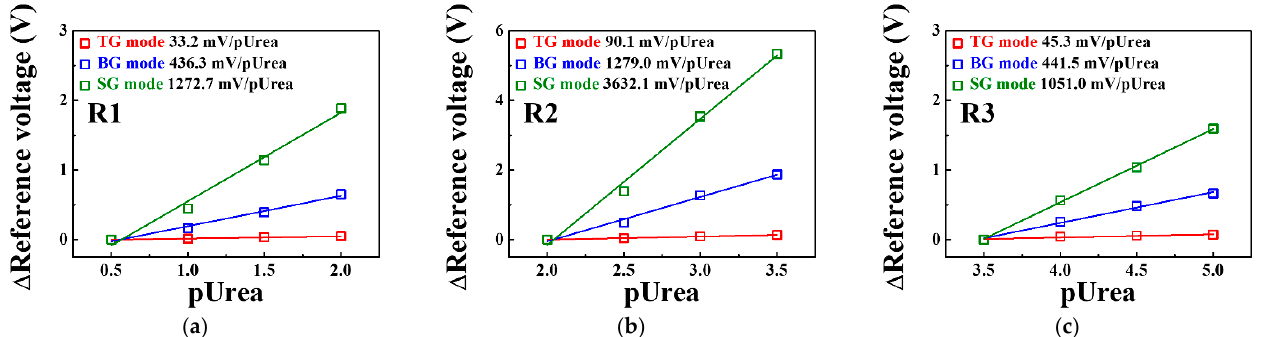
( d ) Figure 10. Transfer characteristic curves in urea-urea reactions of the triple-gate a-IGZO TFT-based urea-EnFET sensor platform in the ( a ) TG, ( b ) BG, and ( c ) SG modes for various urea concentrations. ( d ) Change in the reference voltage of the triple-gate a-IGZO TFT-based urea-EnFET sensor platform as a function of pUrea. Figure 11 shows the urea sensitivity for the SG, BG, and TG modes of the triple-gate a-IGZO TFT-based urea-EnFET sensor platform in the R1, R2, and R3 regions extracted from Figure 10d. In R1, the urea sensitivity in the TG, BG, and SG modes was 33.2, 436.3, and 1272.7 mV/pUrea, respectively. In R2, where the largest signal change was observed, the urea sensitivity in the TG, BG, and SG modes was 90.1, 1279.0, and 3632.1 mV/pUrea, respectively. Finally, in R3, the urea sensitivity of the TG, BG, and SG modes was reduced to 45.3, 441.5, and 1051.0 mV/pUrea, respectively. This result suggests that the urea sensi- tivity of the proposed urea-EnFET sensor platform can be amplified in the BG and SG modes similarly to the sensitivity amplification of the pH-ISFET sensor platform. We